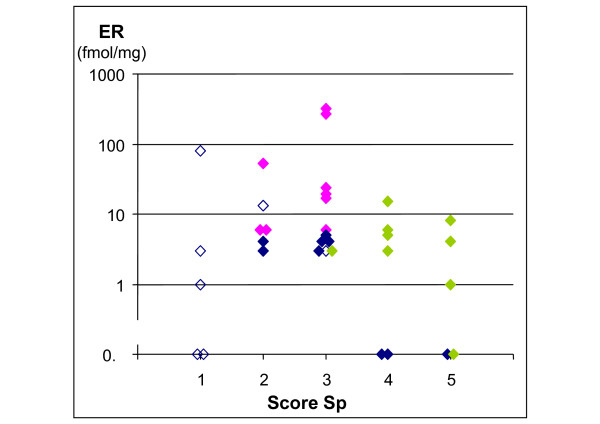
ER content in the five efficacy groups. Ordinate: ER content (fmol/ml); Abscissa: Sp score (score 1: lowest cell kill of non-resistant cycling cells score 5: highest cell kill). Colours refer to the type of model of the best fit. Blue: Level I (without resistance. Open symbols: resistance undetermined; closed symbols: no resistance); Fuchsia: Level II (with resistance); Green: Level III (without resistance, with biphasic efficacy, Sp calculated on the more effective phase).